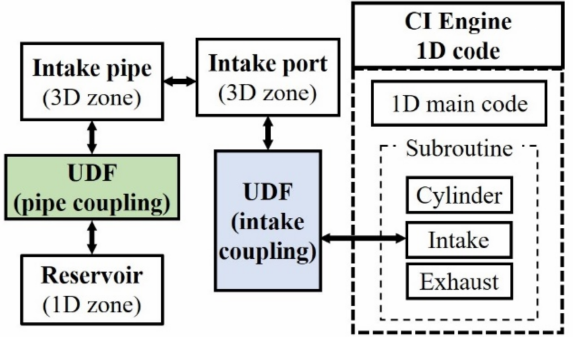
Figure 2. Locations of the user-defined functions in the 1D–3D coupling gas flow